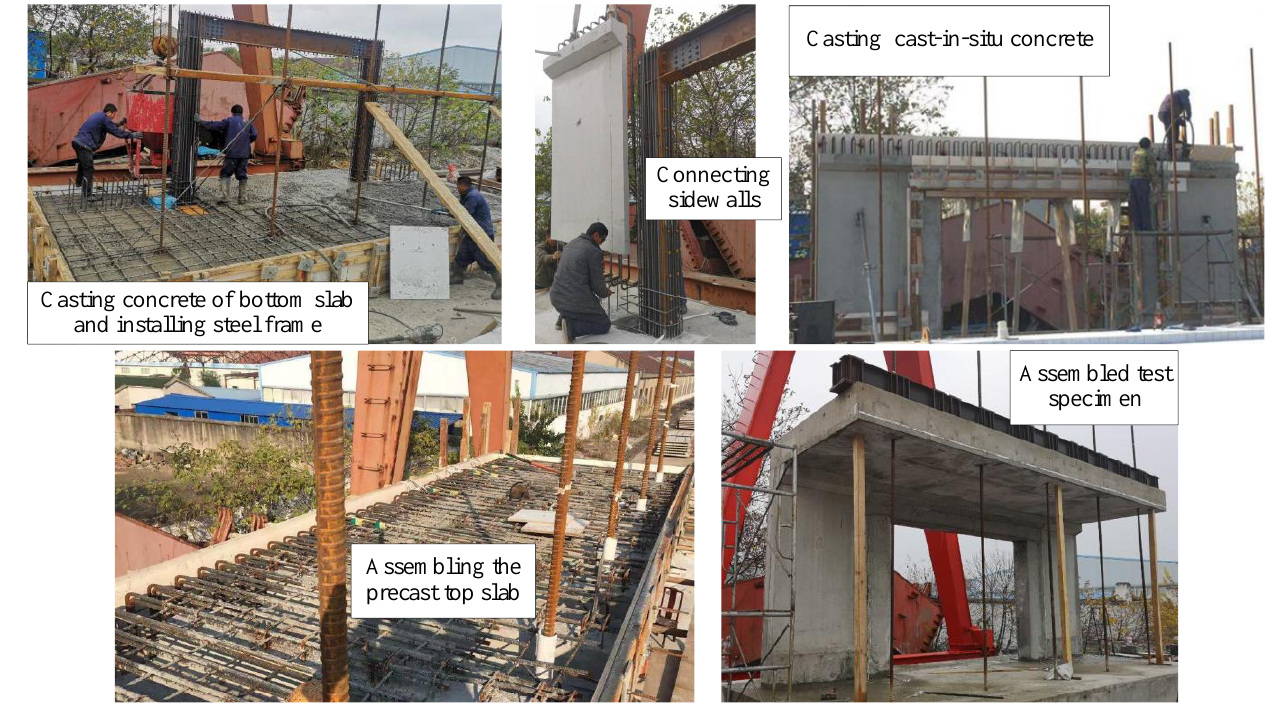
Figure 5. Construction process of the test specimen. Table 2. Material properties of steel